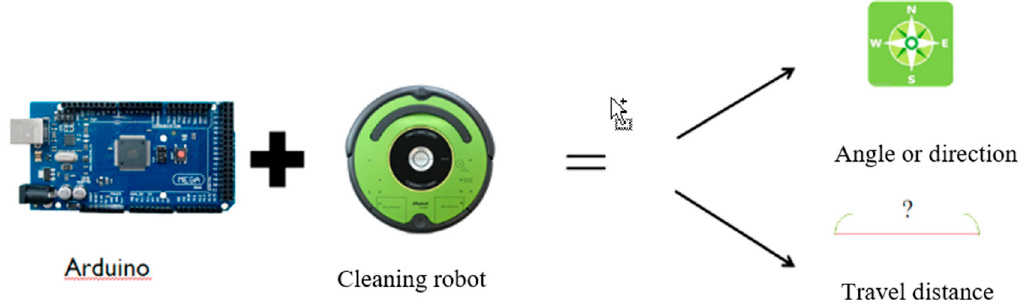
Figure 3. Arduino is used as the platform for calculating travel distance and direction angle.